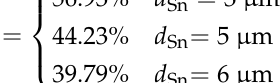
Figure 2. The simplified Au/Sn/Ni/Cu micro-joint.